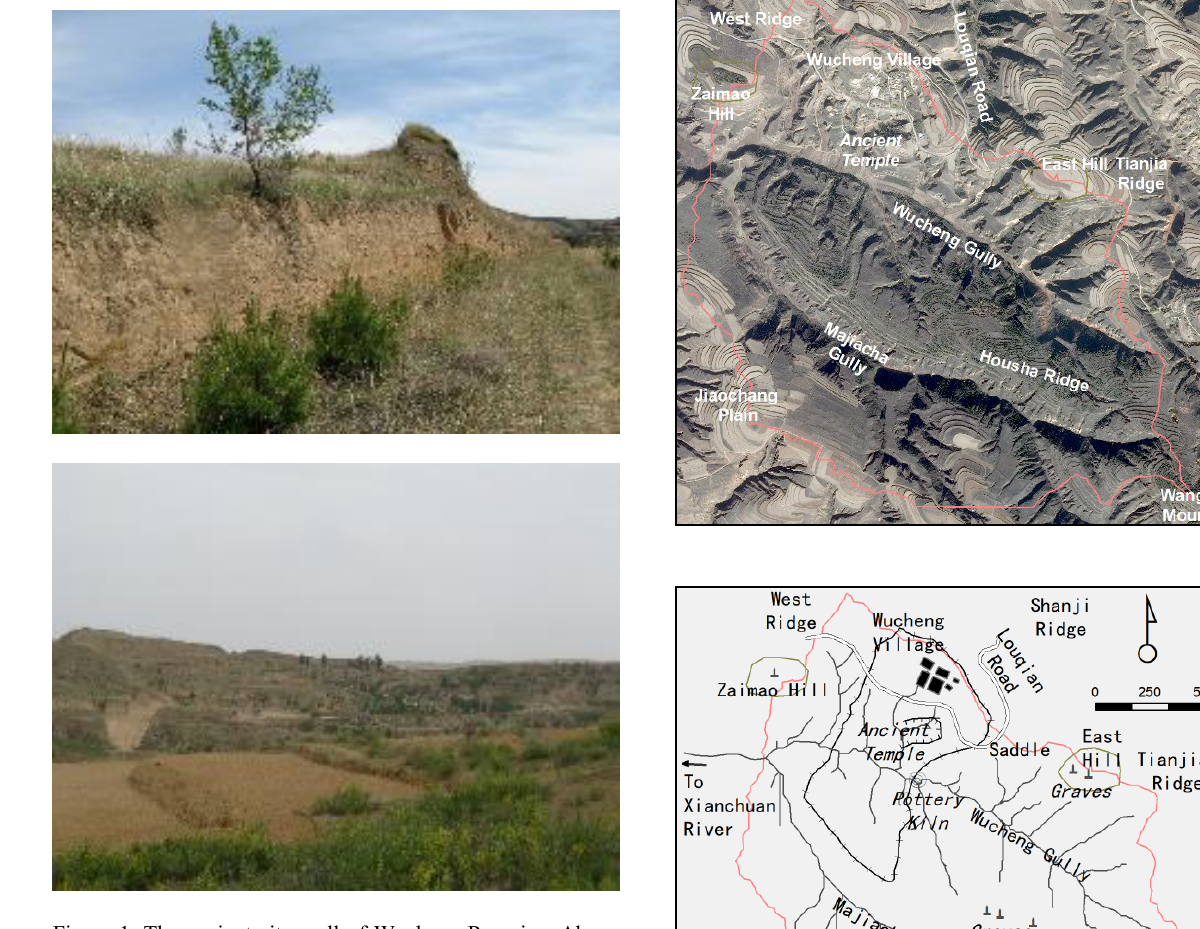
Figure 1. The ancient city wall of Wucheng Remains. Above is the remained city wall; below is an overview of the Remains from the bottom of the gully.